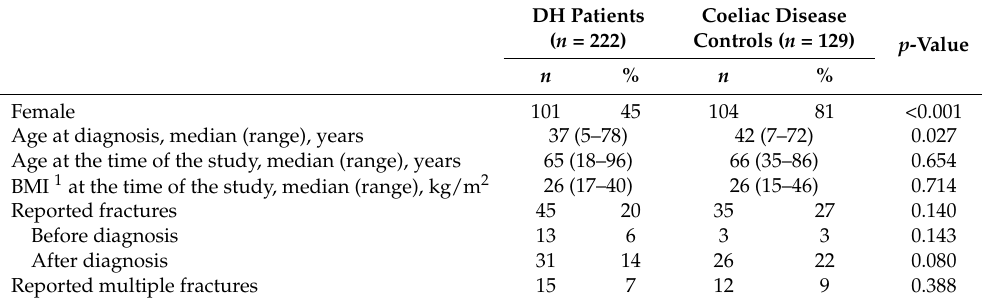
Table 1. Demographic data and reported fractures among 222 dermatitis herpetiformis (DH) patients and the 129 coeliac disease